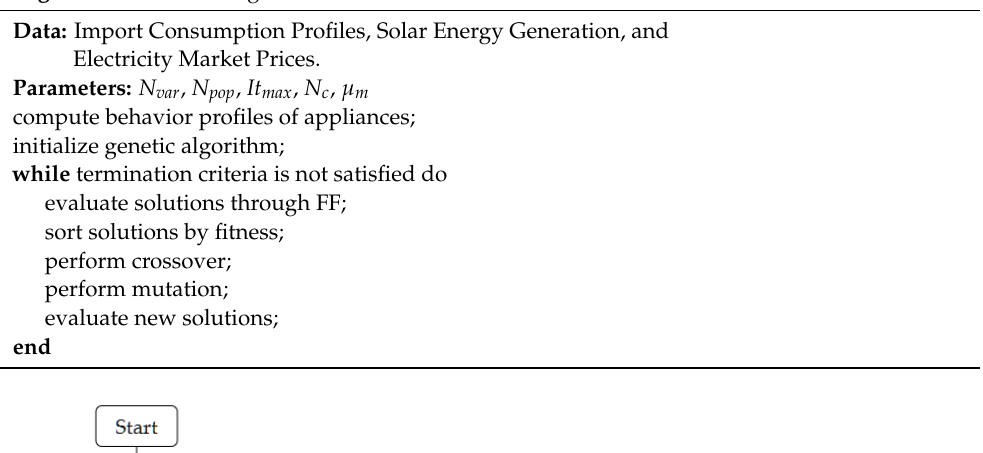
Algorithm 1 Genetic Algorithm